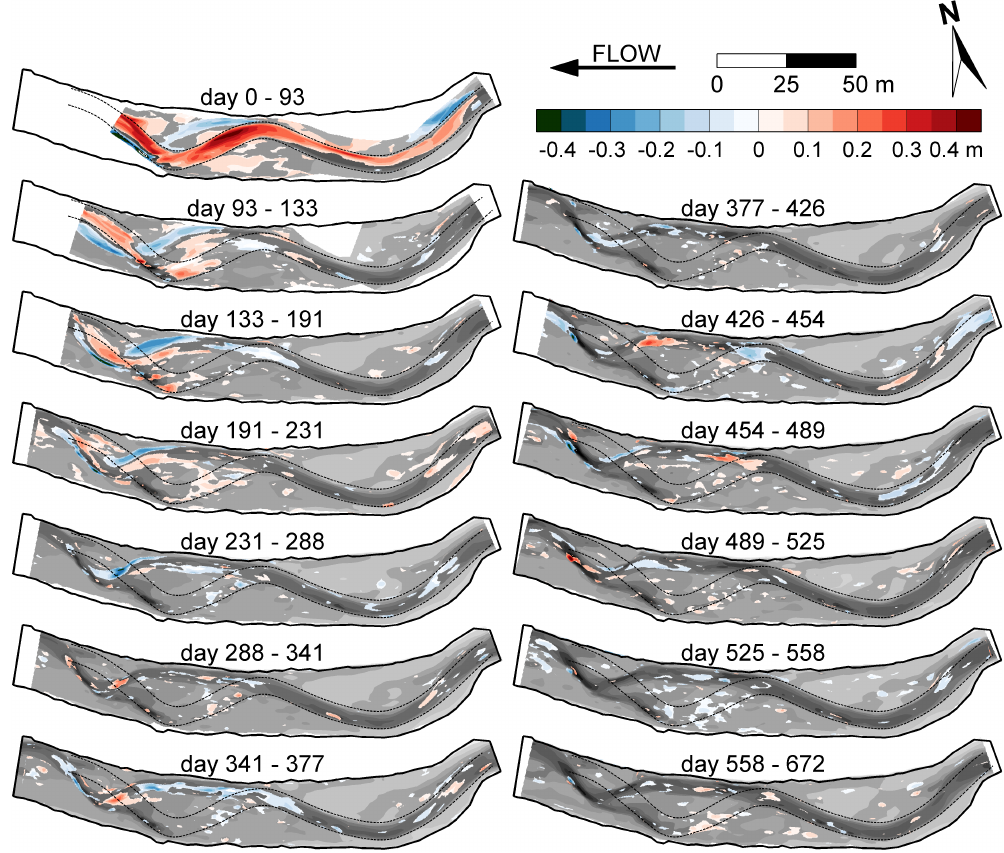
Figure 5. DoDs of all 13 periods between the 14 morphological surveys. The number of days indicates the time since channel reconstruction. The dashed black lines indicate the location of the channel banks of the reconstructed channel. The solid black line surrounding the DEMs indicates the extent of the seventh morphological survey (day 341). Erosion is indicated in blue and deposition in red. The DEM of the first of the two DEMs is shown in